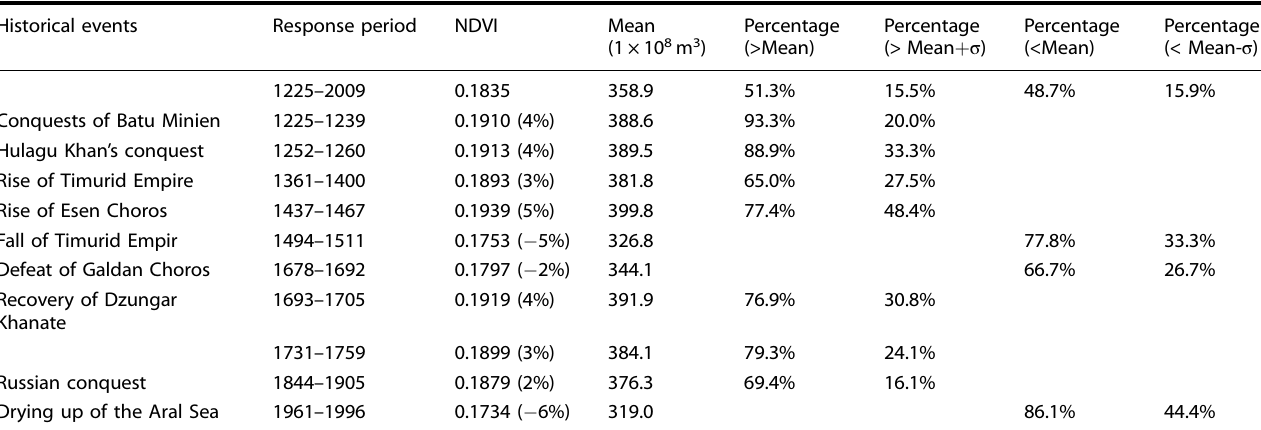
Table 1. Some high and low periods in the stream fl ow reconstruction of Tien Shan Mountains and comparisons with important historical